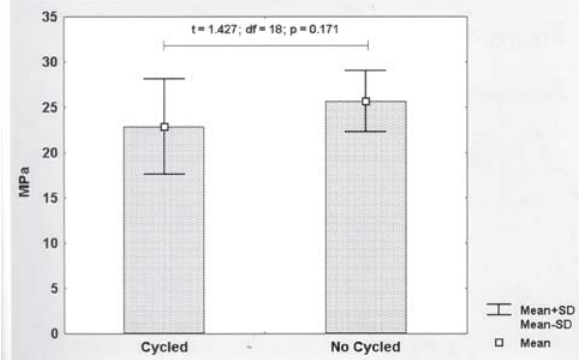
FIGURE 7- Graphic showing results of tensile strength of bonding to In-Ceram ceramic after different storage